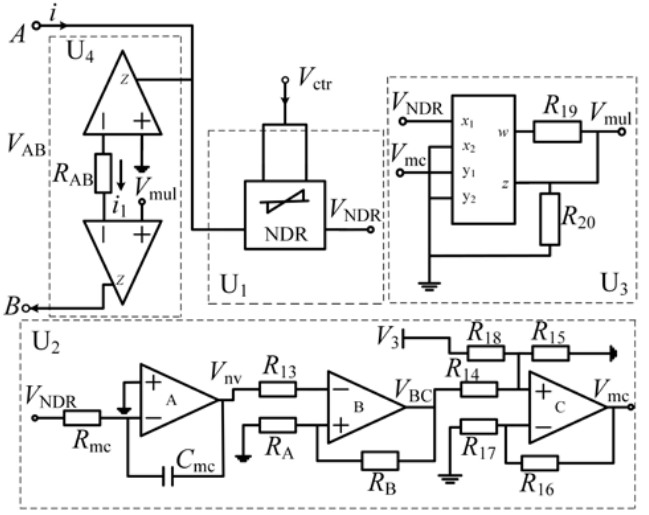
Figure 10. Threshold-controllable memristor emulator circuit based on the improved NDR hysteresis unit.